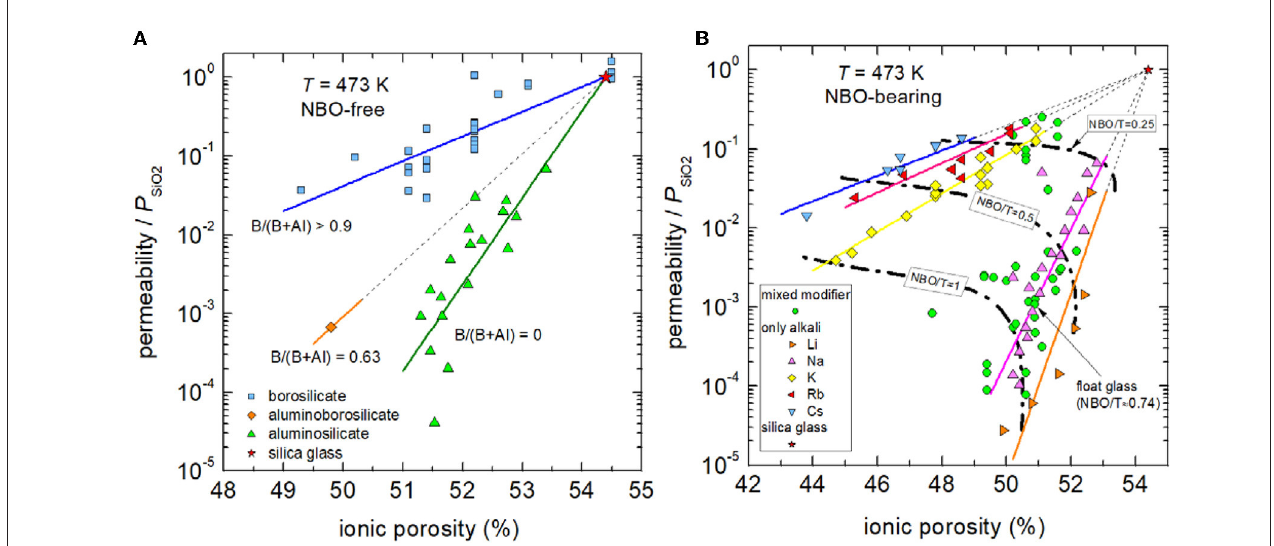
FIGURE 5 | Reduced permeability P / P SiO2 vs. ionic porosity of fully polymerized (A) and depolymerized (B) glasses at 473K. Solid lines are intended as visual guides to indicate compositional trends of borosilicate glasses (blue), aluminoborosilicate glasses (orange), and aluminosilicate glasses (green) in (A) as well as those of binary silicate glasses of cesium (blue), rubidium (red), potassium (yellow), sodium (magenta), and lithium (orange) in (B) . Dashed dotted lines in part B indicate compositions of NBO/T = 0.25, 0.5, and 1. The black arrow due to technical importance emphasizes the data point of soda-lime float glass. Data: see caption of Figure 3 . Note that data for pure silica glasses, titania silicate glasses, and demixed silicate glasses with SiO 2 -rich matrices are not shown.